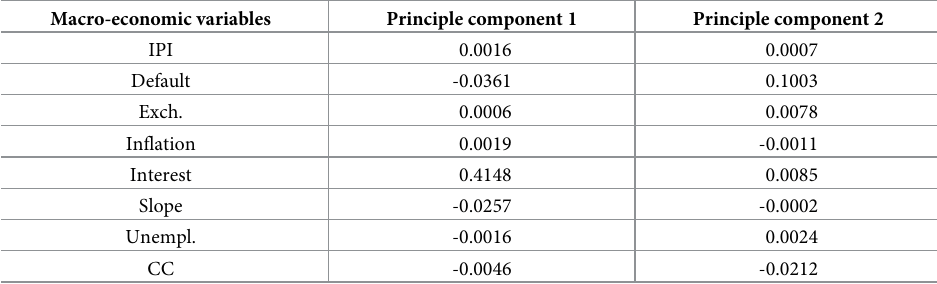
Table 5. Principle component